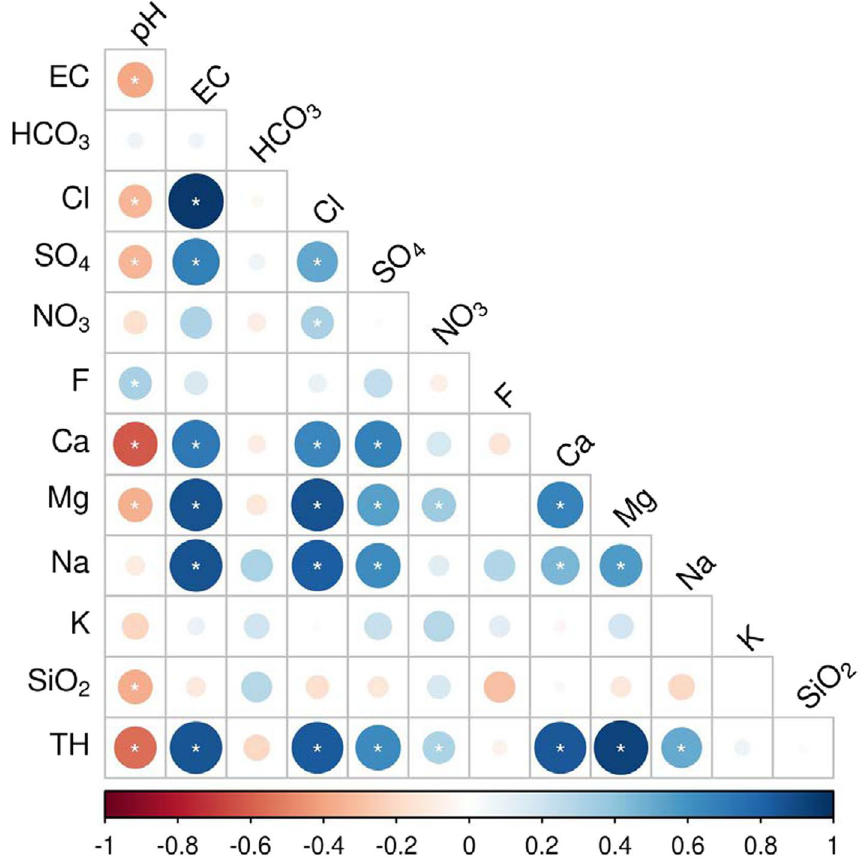
Fig. 6 Correlation ( r ) amongst the geochemical parameters in groundwater over the study area (the asterisk represents the cor- relation to be significant at 90% confidence